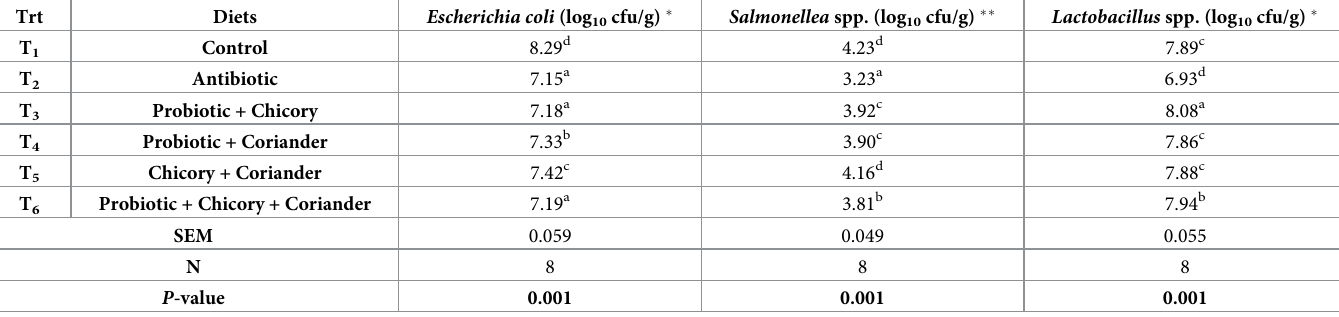
PLOS ONE | https://doi.org/10.1371/journal.pone.0270231 June 27,